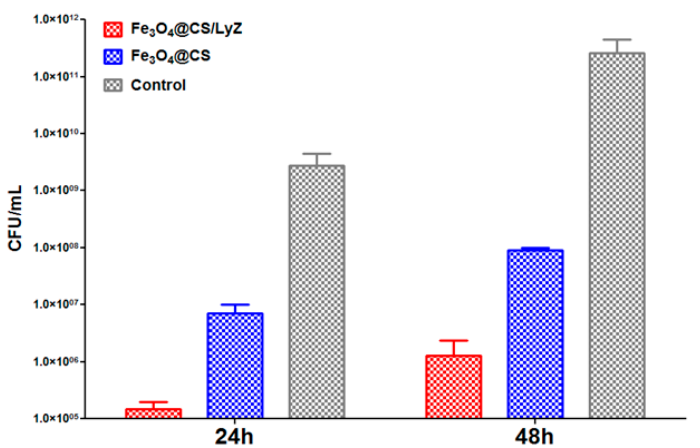
Figure 11. Evaluation of S. aureus microbial biofilm development after 24 and 48 h in the presence of the bioactive nanomodified coatings.